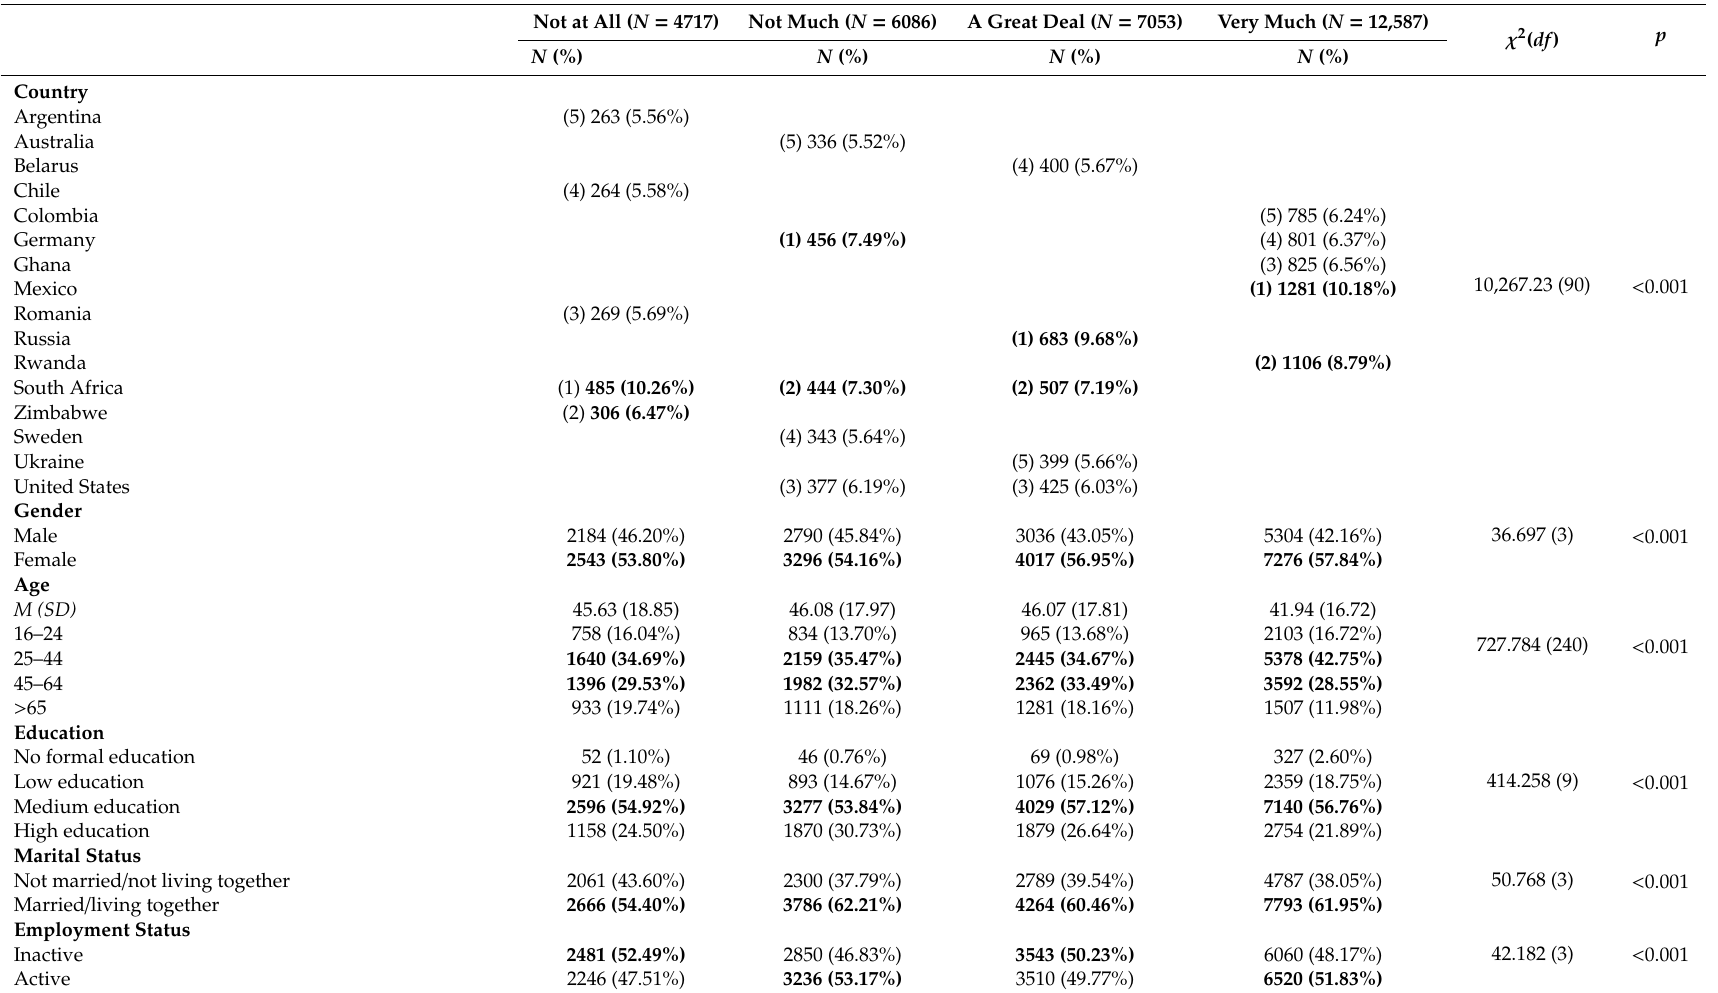
Table 2. Sample distribution relating the concern about the terrorist